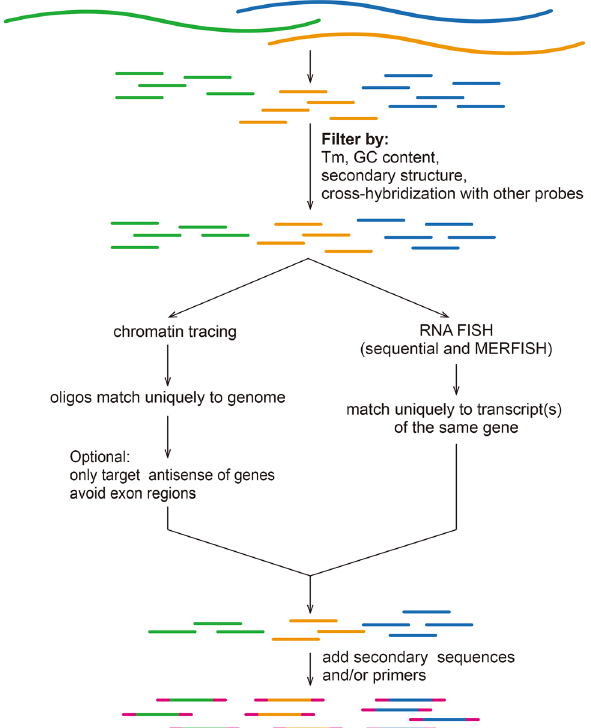
Figure 1. Probe design workflow. ProbeDealer scans input sequences to generate oligos of defined length, and filters the oligos according to their physical properties. ProbeDealer then examines the specificity of these probes, and outputs probes with appended priming regions for probe synthesis and secondary sequences for